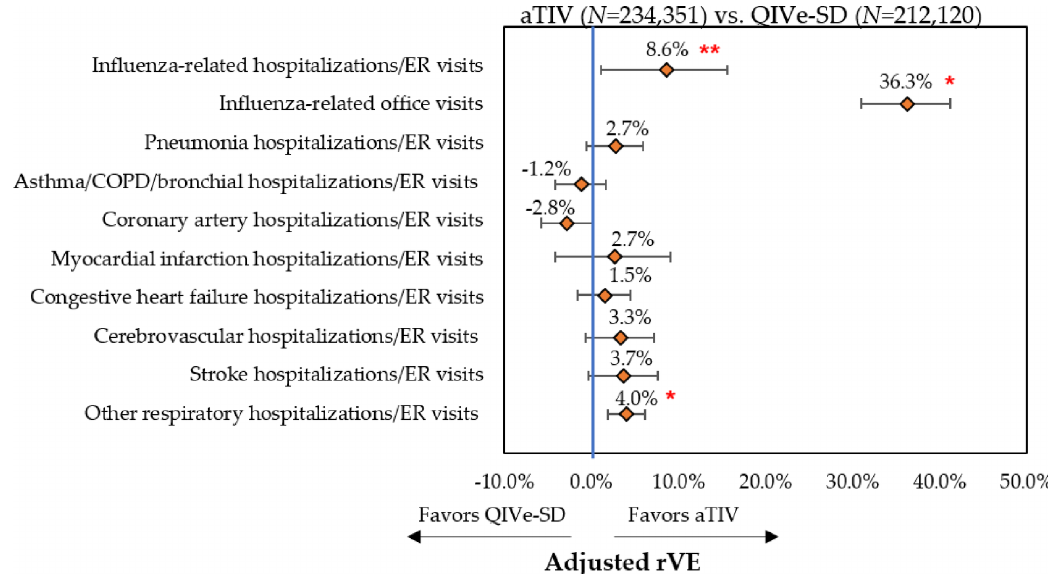
Figure 6. Adjusted rVE — post-IPTW and Poisson regression — aTIV vs. QIVe-SD. * p < 0.001; ** p < 0.05; rVE = relative vaccine effectiveness.